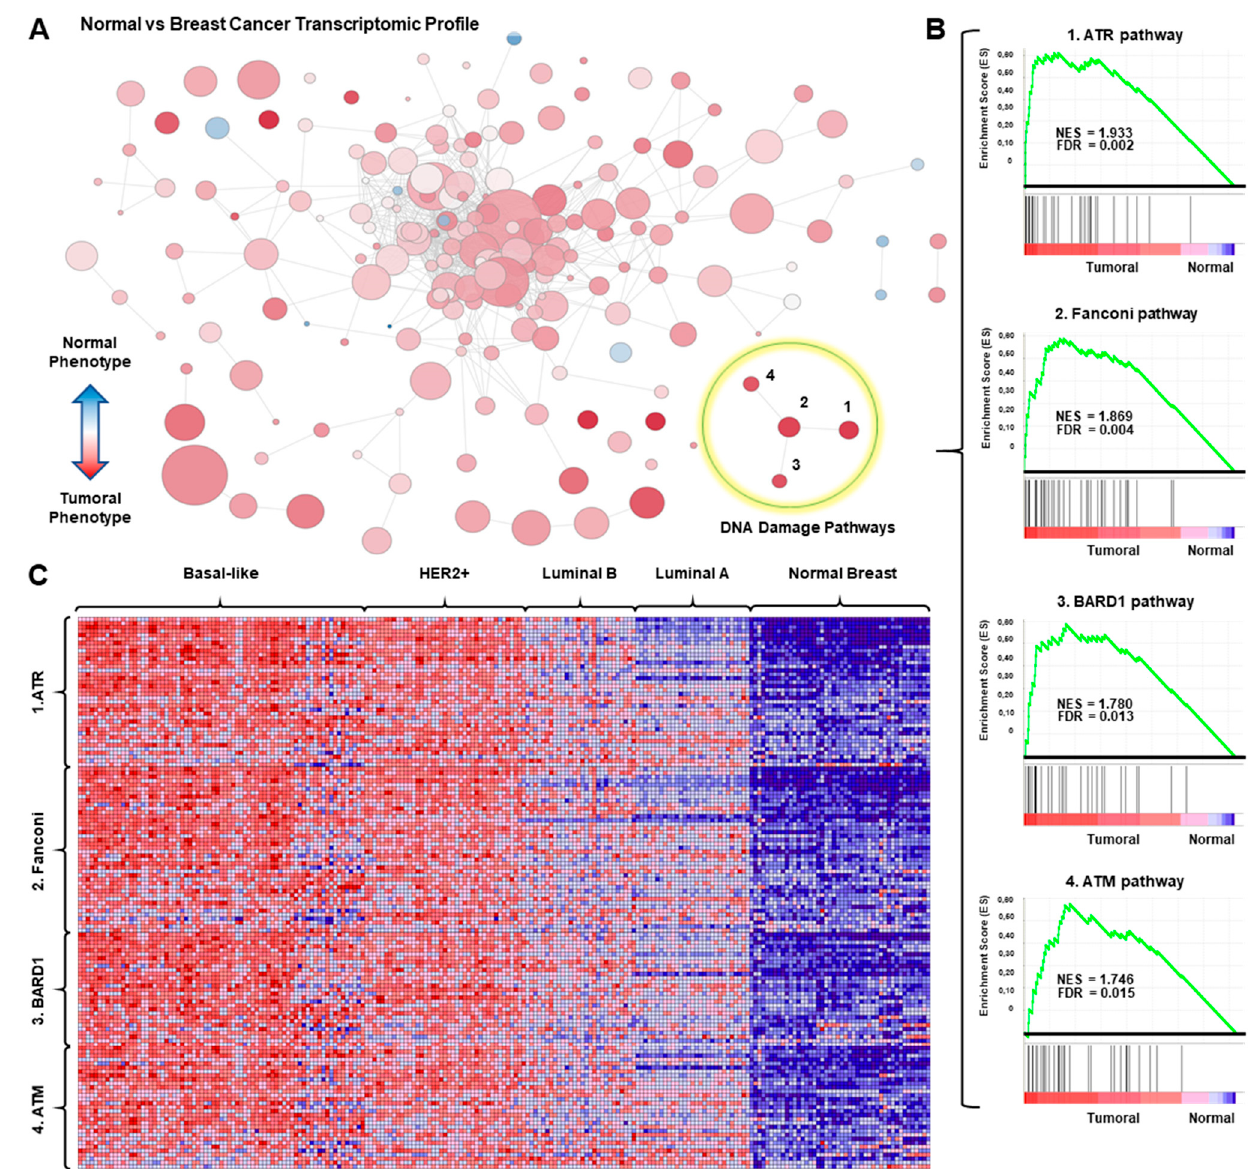
Figure 1. Upregulation of DNA damage pathways in breast cancer. ( A ) Gene set enrichment network comparing normal versus breast tumoral tissue. All gene sets from the Pathway Interaction Database are included, those overexpressed in the tumoral phenotype, are displayed in shades of red, and those overexpressed in the normal phenotype are displayed in shades of blue; while the size of the circle indicates the number of genes within the gene set. ( B ) ES Score profile and locations of DNA Damage pathways “ ATR pathway”, “ Fanconi Anemia pathway”, “BARD1 pathway,” and “ ATM pathway” members on the rank ordered list. Positive NES defines tumoral phenotype enrichment. ( C ) Blue–red diagram of all the genes that composed the DNA Damage pathways showing overexpressed genes in shades red, and downregulated genes in shades of blue.